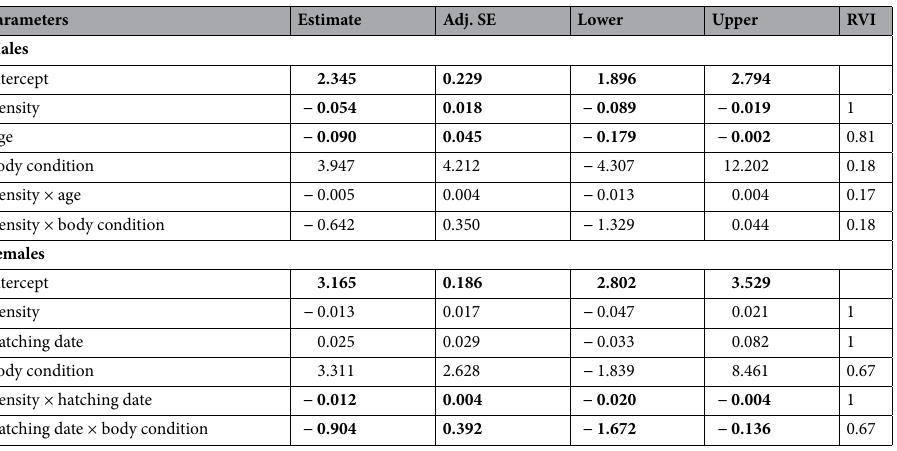
Table 2. Conditional model averaging of the top-ranked models (delta AICc < 2), examining the correlates of natal dispersal distances of male and female Egyptian vultures at the local scale (Ebro valley). Model average parameter estimates, adjusted standard errors, 95% confidence intervals and relative variable importance (RVI, the sum of Akaike weights over the set of models in which the variable appears) are shown. Effects with 95%CI not overlapping zero are shown in bold.